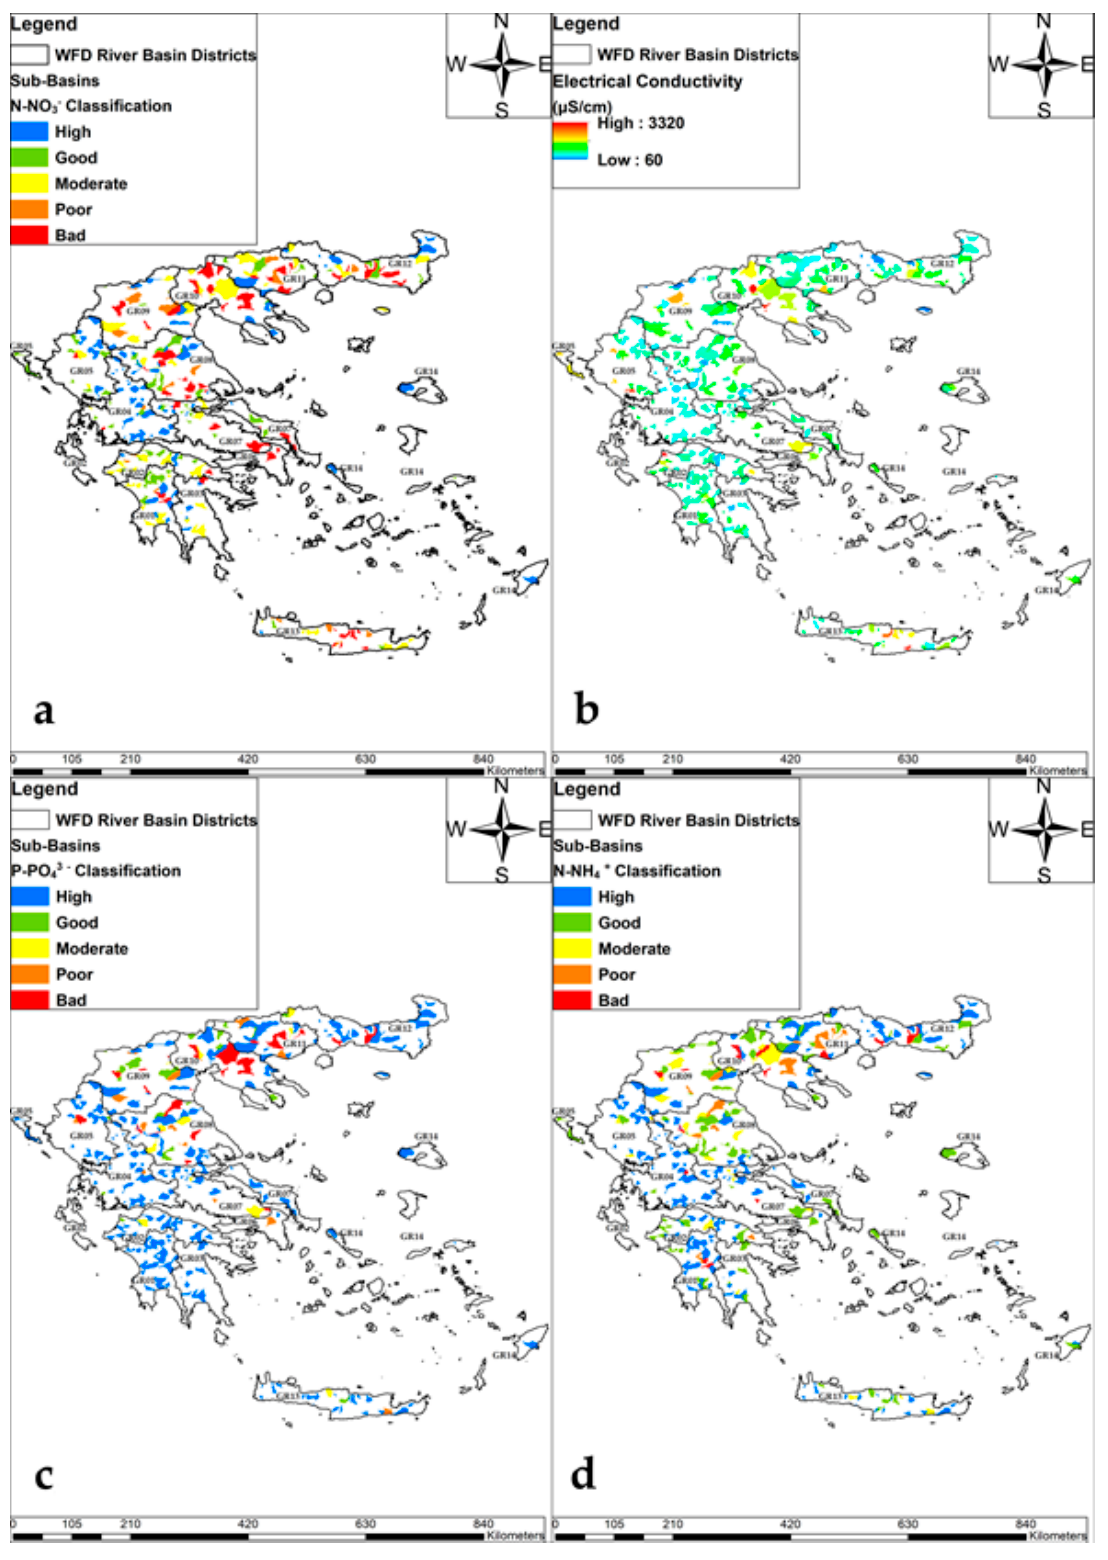
Figure 9. Physicochemical status of the selected parameters at sub-basin scale: ( a ) Nitrate, ( b ) Electrical conductivity ( µ S / cm), ( c ) Phosphate, and ( d ) Ammonium. Classification of nitrate, phosphate and ammonium into the five classes of nutrient quality follows the Nutrient-quality Classification System (NCS) [18].